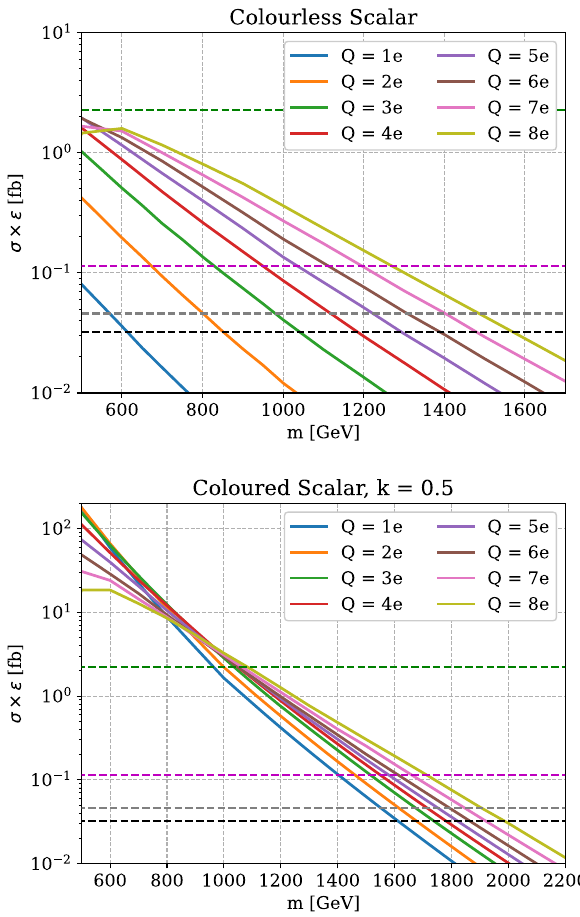
(magenta), 300 (grey) and 3000 fb − 1 (black). Top right: same but for colourless fermions. Bottom left: same but for coloured scalars. Bottom right: coloured fermions